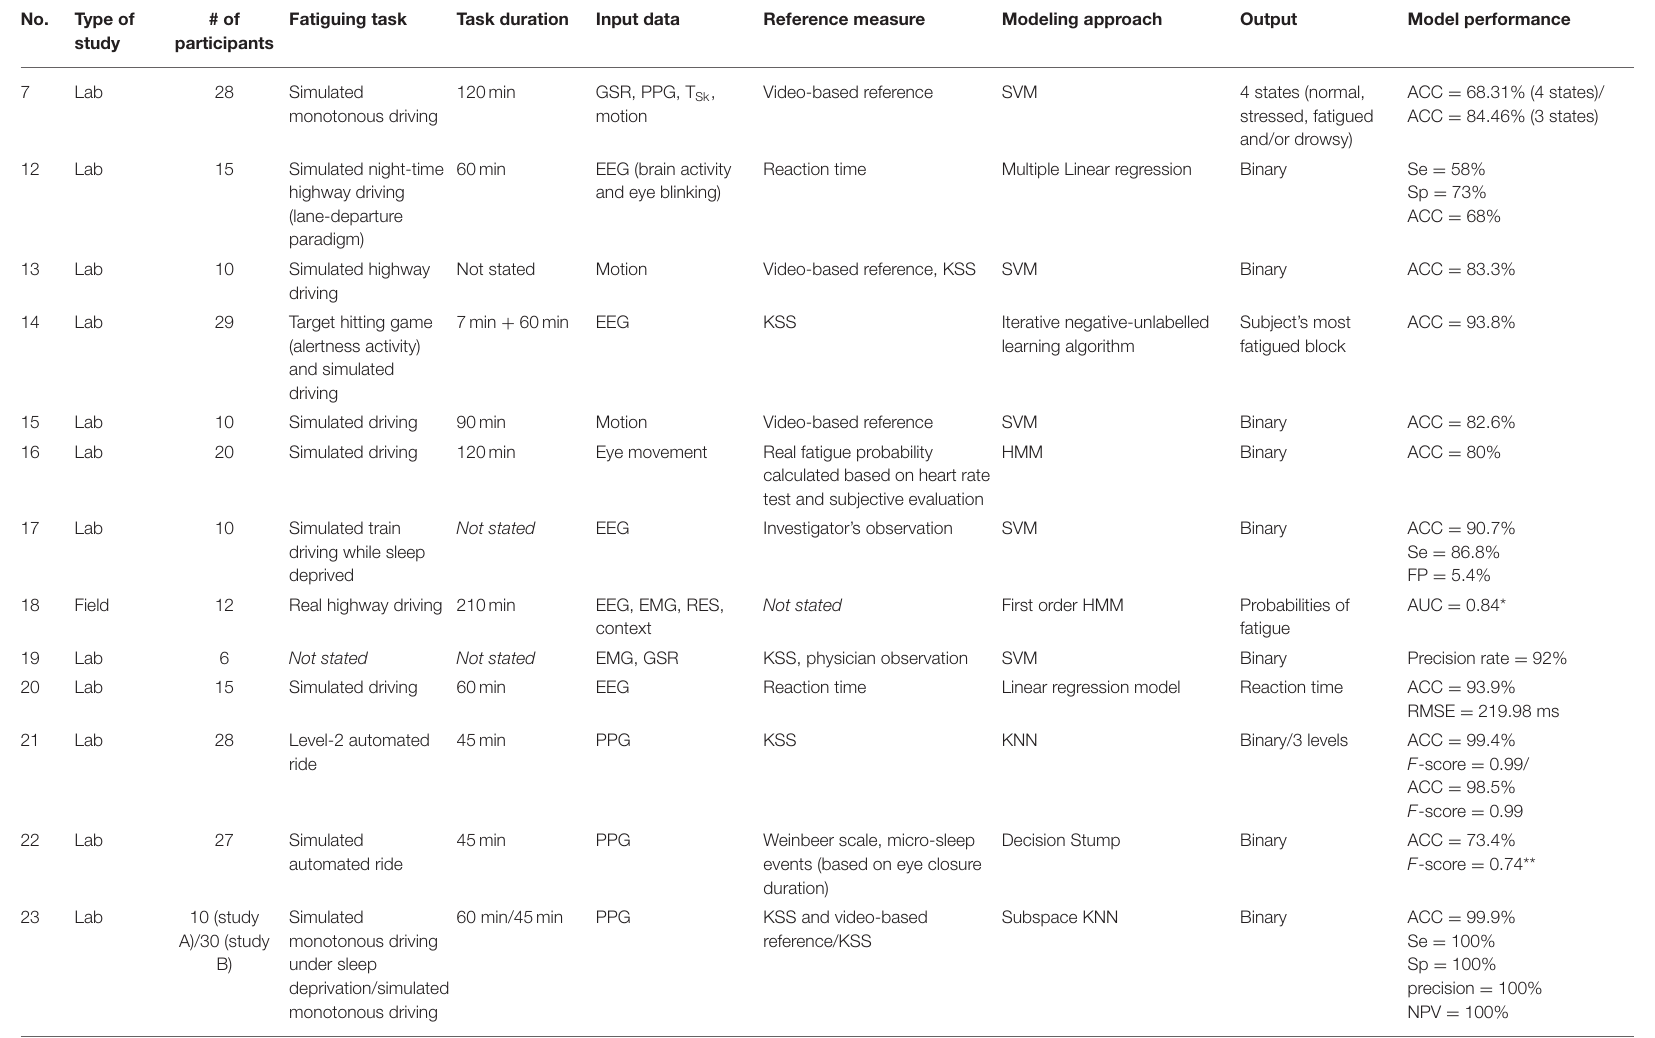
TABLE 5 | Summary of characteristic of studies that investigated drowsiness quantification using wearable devices.